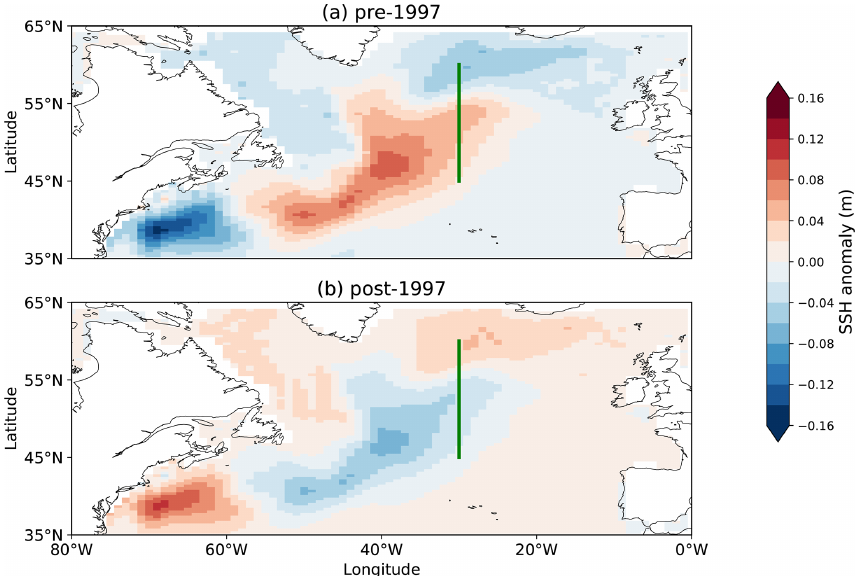
Figure 3. Mean anomaly maps of sea surface height (SSH): (a) pre-1997; (b) post-1997. Data from GODAS. Anomalies calculated with respect to the 1980–2020 climatology. The green line at 30 ◦ W shows the meridional profile used for eastward transport calculations between 45 and 60 ◦ N.